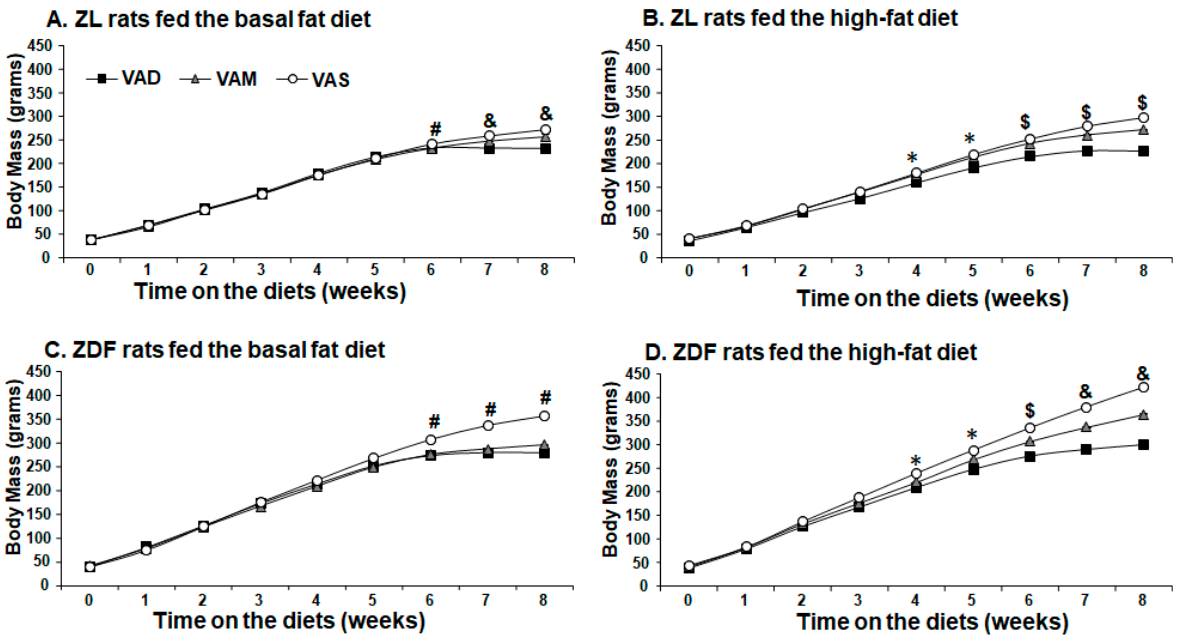
Figure 1. Body Mass of ZL or ZDF rats fed a VAD, VAM or VAS diet with BF or HF content for 8 Weeks . The body mass of ZL and ZDF rats was measured weekly. Data were expressed as mean ± SEM; n = 5–6 per dietary group; * For VAD < VAS; # for VAD/VAM < VAS; $ for VAD < VAM/VAS; & for VAD < VAM < VAS using one ‐ way ANOVA at the time point indicated; all p < 0.05. The weekly food intake of ZL rats fed the VAS ‐ BF diet was lower than that of the rats fed the VAD ‐ BF diet and that of the rats fed the VAM ‐ BF diet at weeks 2 and 7, respec ‐ tively, as shown in Figure 2A. The weekly food intake of ZL rats fed the VAD ‐ HF diet was lower than that fed the VAS ‐ HF diet at weeks 7 and 8, as shown in Figure 2B. The weekly food intake of ZDF rats fed the VAD ‐ BF diet was not different from that of the rats fed the VAM ‐ BF or VAS ‐ BF diet, as shown in Figure 2C. The weekly food intake of ZDF rats fed the VAD ‐ HF diet was lower than that of the rats fed the VAM ‐ HF diet and that of the rats fed the VAS ‐ HF diet at weeks 6–8 and 7–8, respectively, as shown in Figure 2D. There 6.5) and OGTT (week 7.5) (Figure 2).